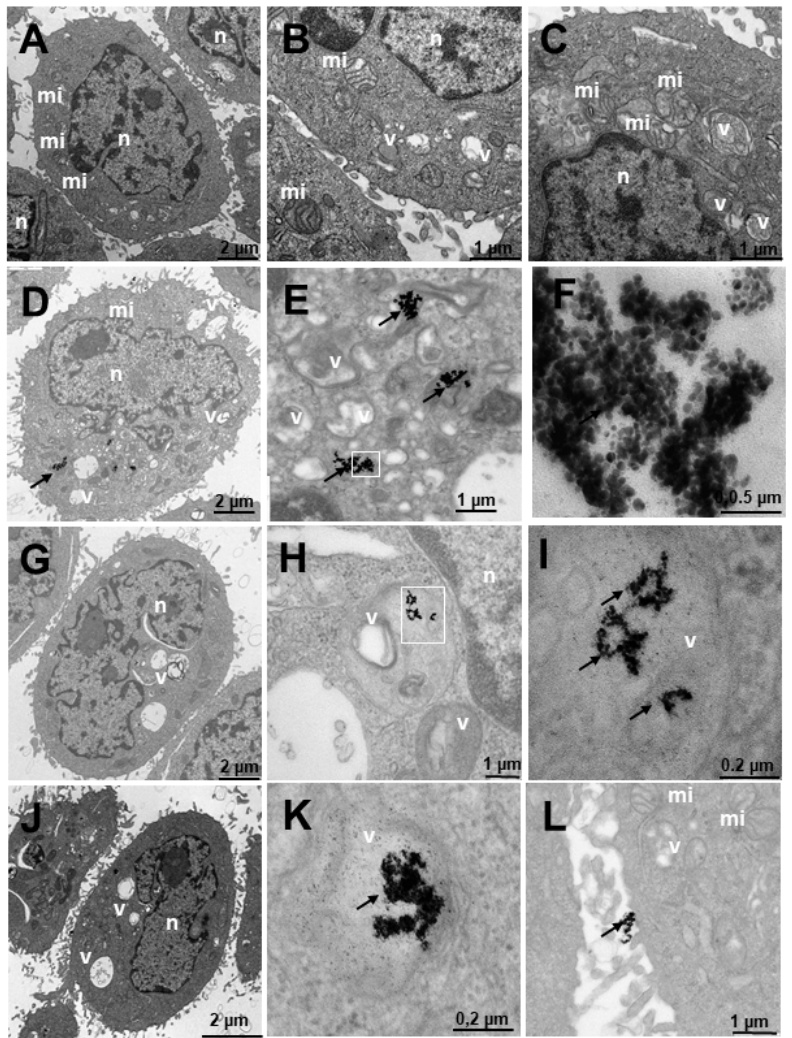
Figure 9. Transmission electron microscopy (TEM) photomicrographs of control cells without treatment ( A – C ), compared to Au@16-Ph-16 (N 3 ) ( D – F ), Au@16-Ph-16/DNA/Doxo (C 3 ) ( G – I ) and Au@16-Ph-16/DNA/Doxo + Au@16-Ph-16 (C 3 + N 3 ) ( J – L ) at 24 h, in non-tumorigenic prostate PNT2 cells. The dense bodies indicated by an arrow are compatible with the gold cores of the